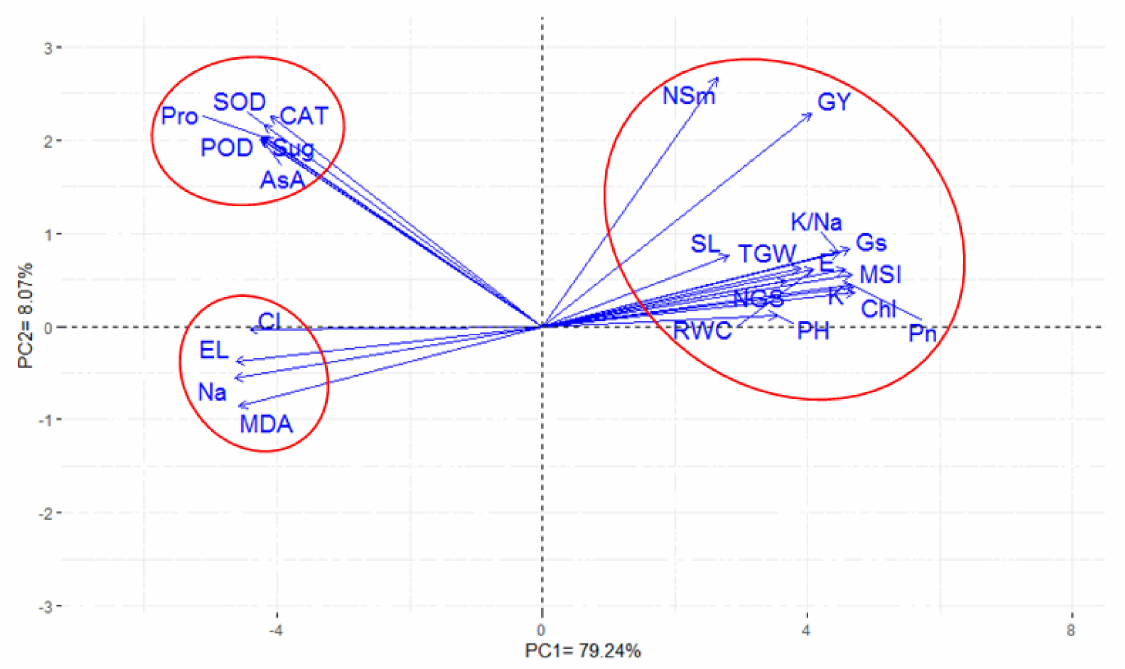
Figure 2. Biplot of the principal component analysis for the first two principle components of agronomic and physiological traits at three salinity levels. PH is plant height, SL is spike length, NSm is number of spikes per square meter, NGS is number of grains per spike, TGW is 1000-grain weight, GY is grain yield, Chl is total chlorophyll, Pn is net photosynthetic rate, E transpiration rate, Gs is stomatal conductance, RWC is relative water content, MSI is membrane stability index, Sug is soluble sugars content, Pro is free proline content, AsA is ascorbic acid, SOD is superoxide dismutase, CAT catalase, POD peroxidase, MDA is malondialdehyde, EL is electrolyte leakage, Cl is chlorine content, Na is sodium content, K is potassium content, and K / Na is K / Na